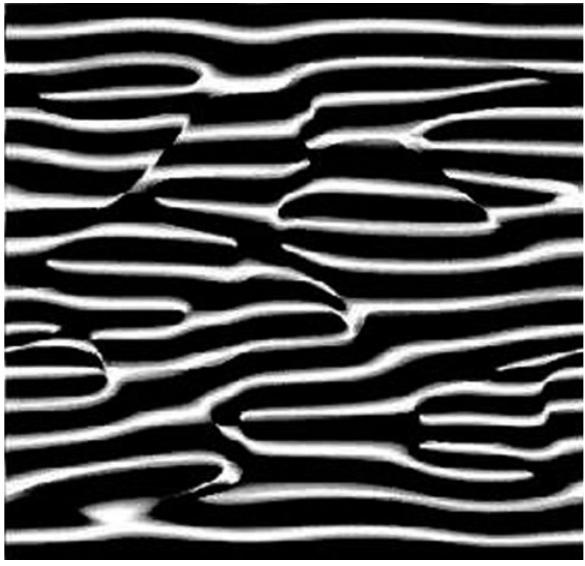
Figure 2 View of moir é pattern v(x,